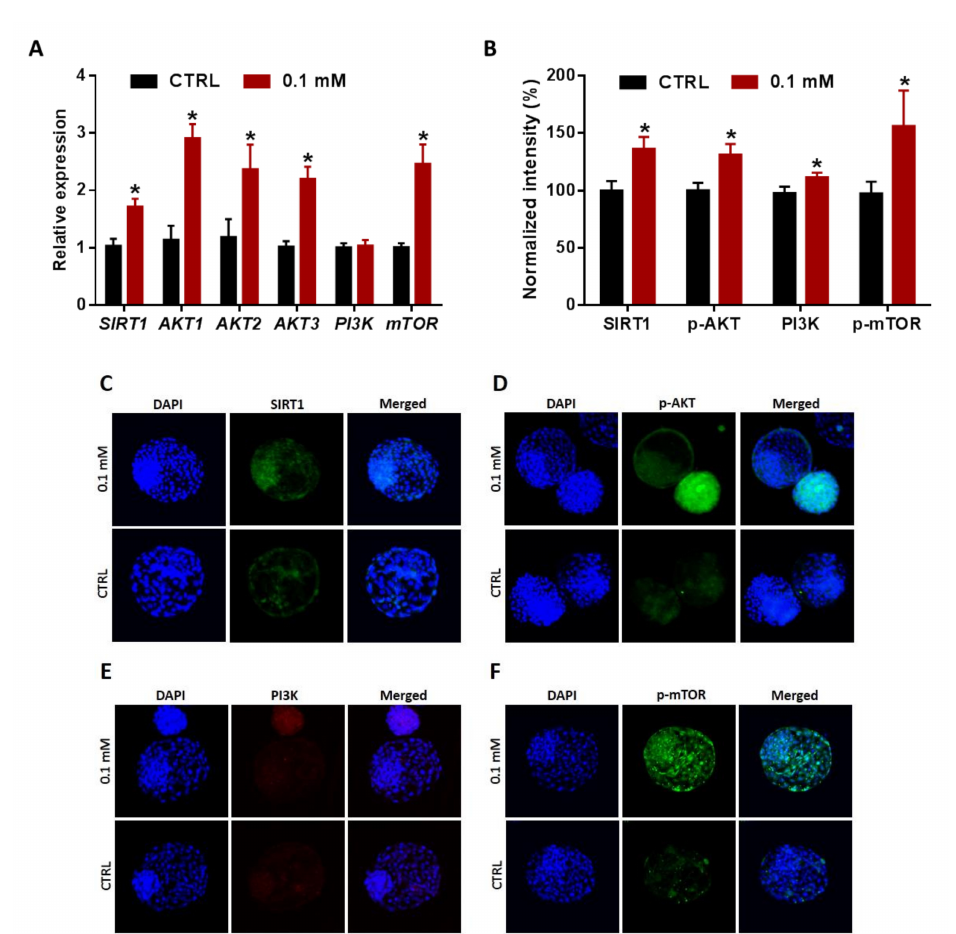
Figure 7. Expression of SIRT1, AKT, PI3K, and mTOR in day-8 blastocysts. ( A ) The mRNA levels of SIRT1, AKT1, AKT2, AKT3, PI3K , and mTOR in embryos developed from oocytes treated with 0.1 mM NAM. ( B ) Integrated optical density of SIRT1, p-AKT-Ser473, PI3K, and p-mTOR in NAM-treated and control embryos. Immunofluorescence of SIRT1 ( C ), p-AKT-Ser473 ( D ), PI3K ( E ), and p-mTOR ( F ) in blastocysts. Original magnification 100 × . The asterisk indicates statistical